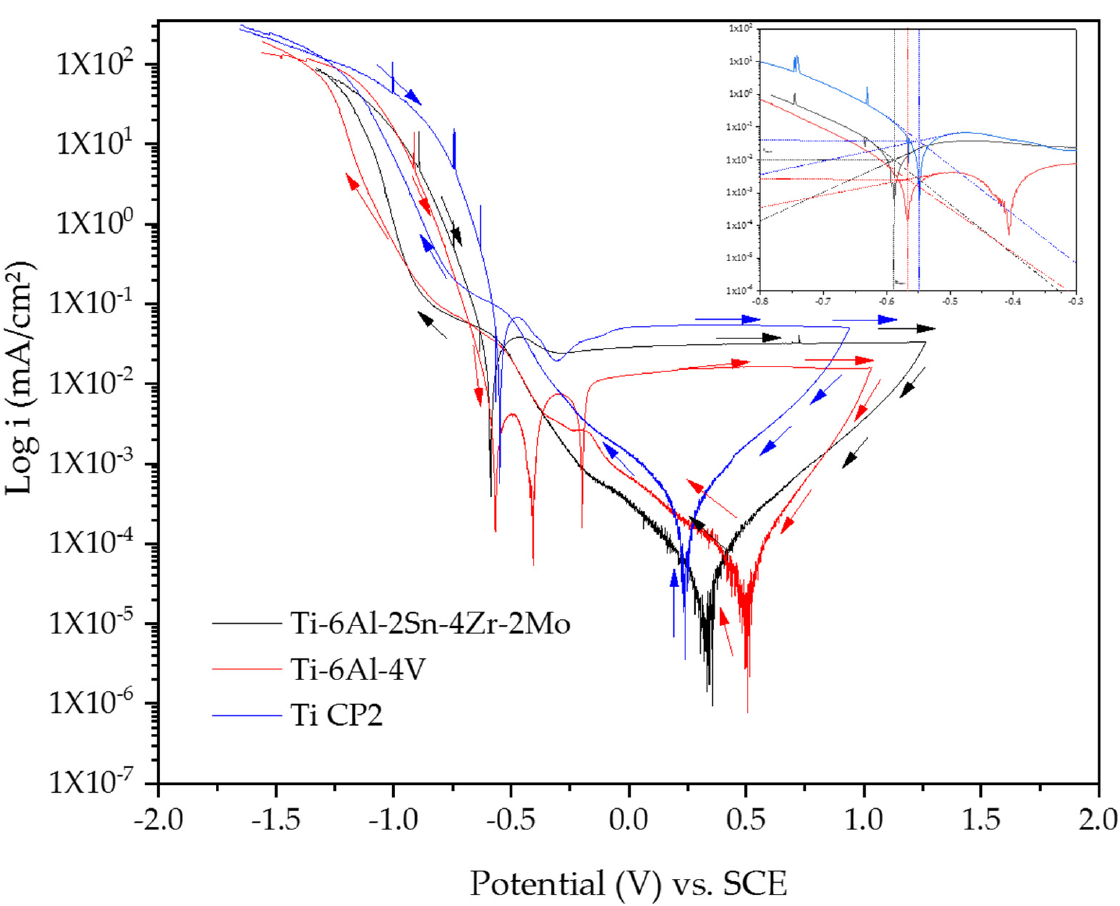
Figure 3. Cyclic potentiodynamic polarization curves of titanium alloys exposed in a 3.5 wt % H 2 SO 4 solution.